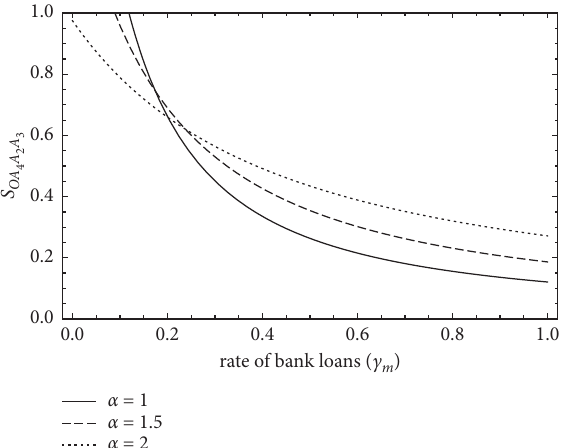
Figure 6: The impacts of the manufacturer loan rate on S with various financial risk factors.